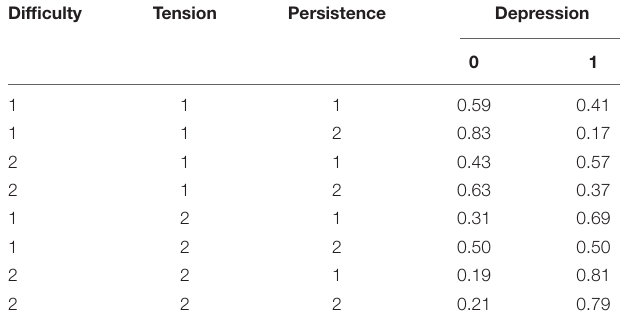
TABLE 8 | Conditional probability of